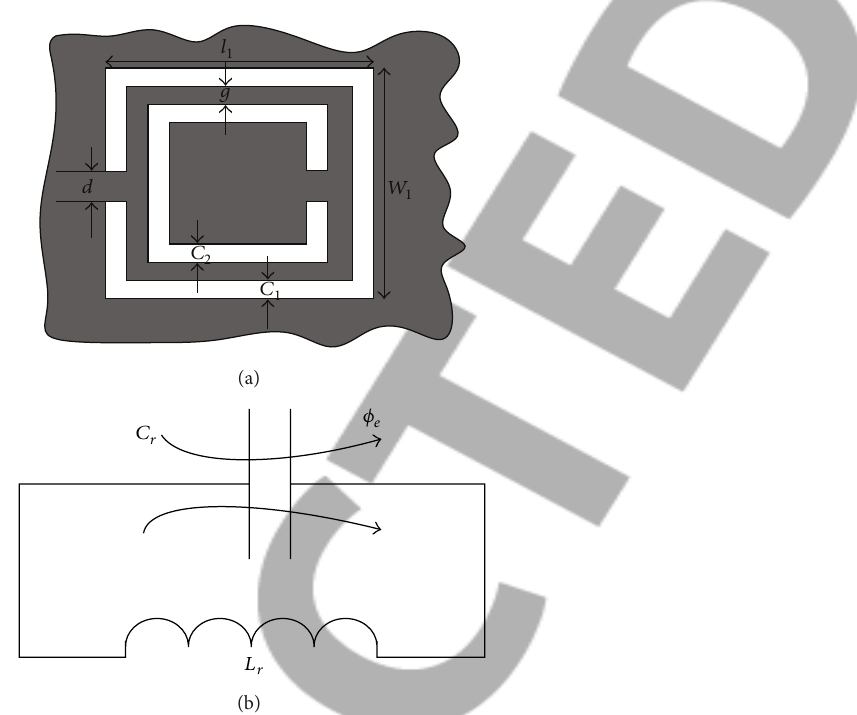
Figure 1: (a) Topology and (b) its equivalent circuit model of the SSRR [9]. Gray zone represents the metallization.